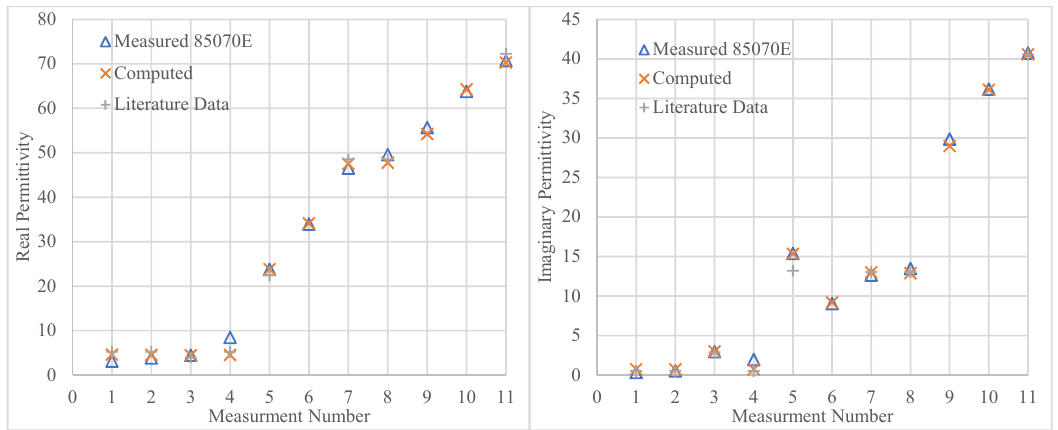
Figure 9. Plots comparing the actual measurement values (blue) with the predicted (orange) values for 11 measurement points. Probe used: Slim Form; Calibration point: VNA test port; data predicted: permittivity at 2.45 GHz. Available literature data: Fat [42], Propan-2-ol and Methanol [43], Liver [33], 0.5 M NaCl [44]. Table 3. The measurement number and corresponding material name for the results shown Figure 9, with accompanying references to available relevant published